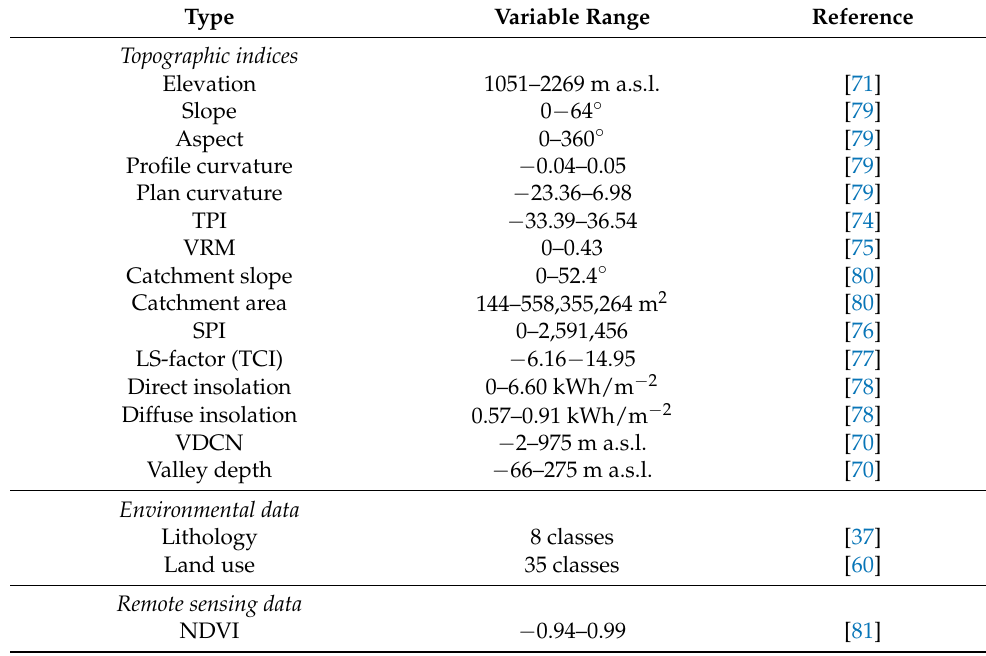
Table 1. Environmental predictors for maximum entropy